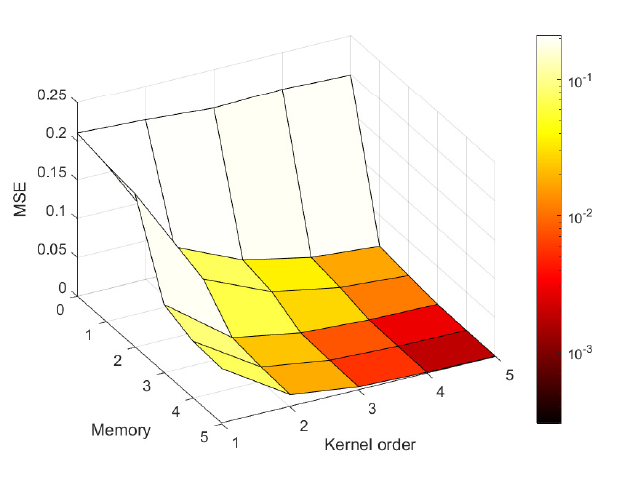
Figure 5. Mean squared error dependence on the memory and order of the Volterra representation of the inverse system.